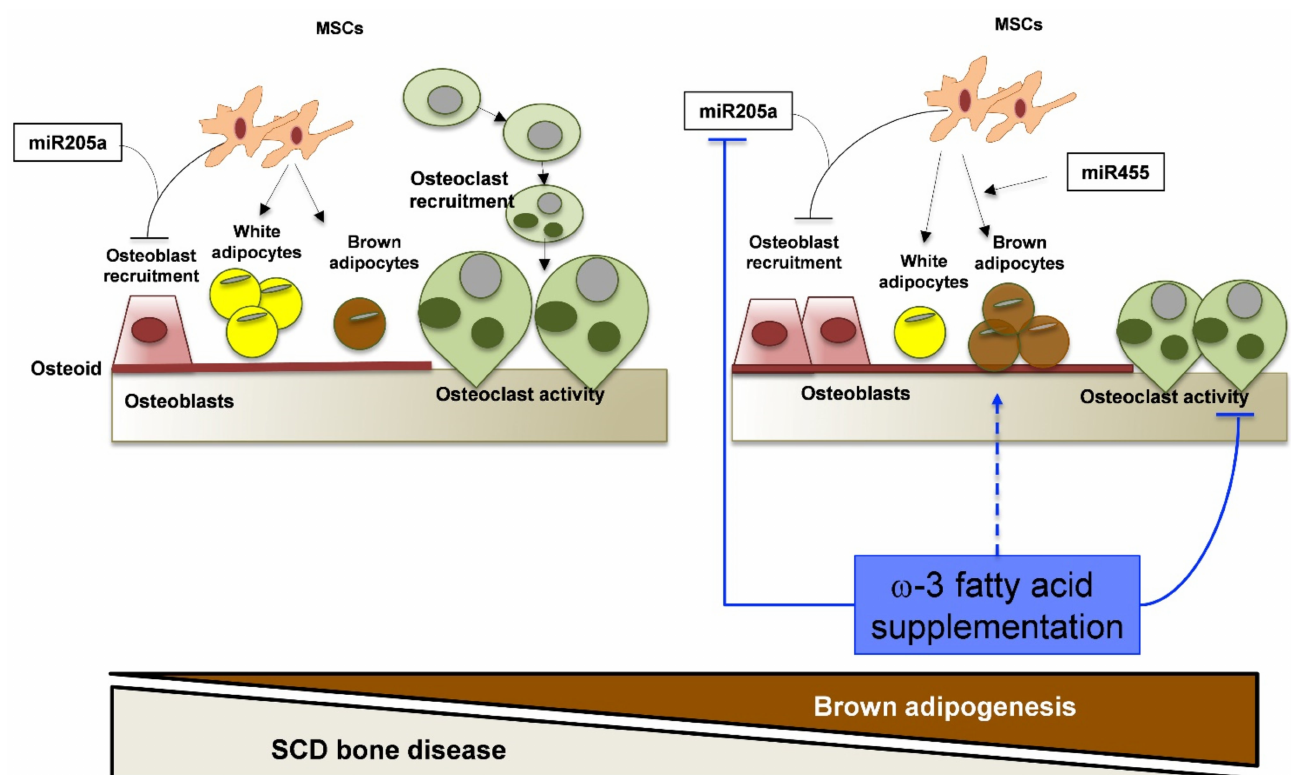
Figure 5. Schematic diagram of the multimodal action of FD supplementation that ameliorates sickle cell bone disease. SCD mice display increased osteoclast recruitment/activity and reduced osteoblastogenesis/activity, ending in reduced osteoid formation and bone loss. miR205a negatively affects osteoblast recruitment in favor of adipogenesis, mainly represented by white adipocyte tissue. FD supplementation reduces osteoclastogenesis/osteoclast activity and downregulates miR205a, favoring osteoblastogenesis/activity. Finally, FD re-programing of adipogenesis resulted in the browning of white adipocyte tissue. The multimodal action of FD protects bone from sickle cell related tissue damage. SCD: sickle cell disease; MSC; mesenchymal stem